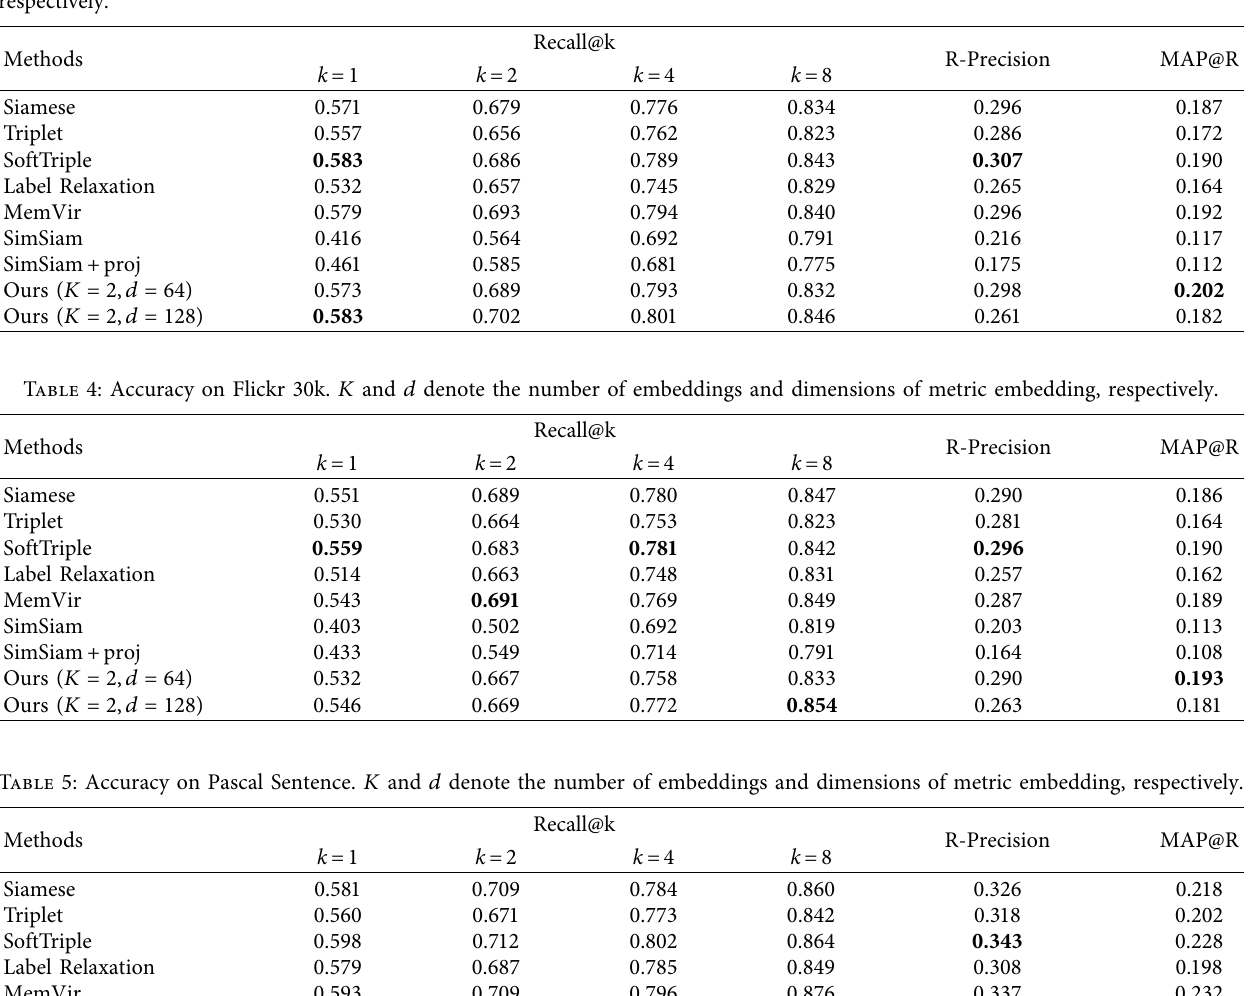
Table 3: Accuracy on MSCOCO. K and d in PTF-SimCM denote the number of embeddings and dimensions of metric embedding, respectively.